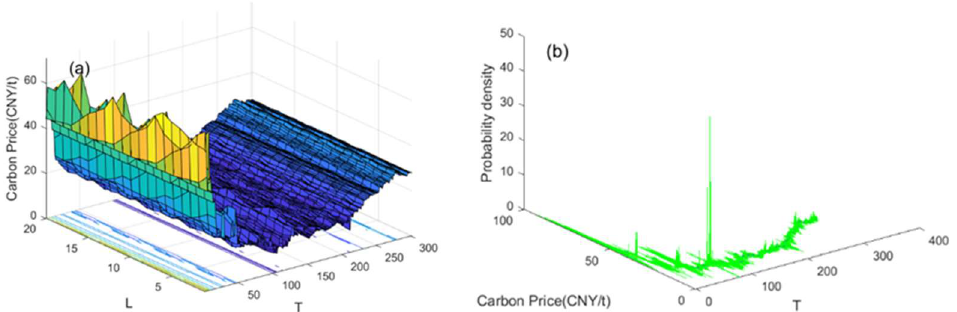
Figure A2. Price data and probability density distribution of carbon market in Chongqing, ( a ) evo- lution of daily closing price data; ( b ) distribution of probability density.